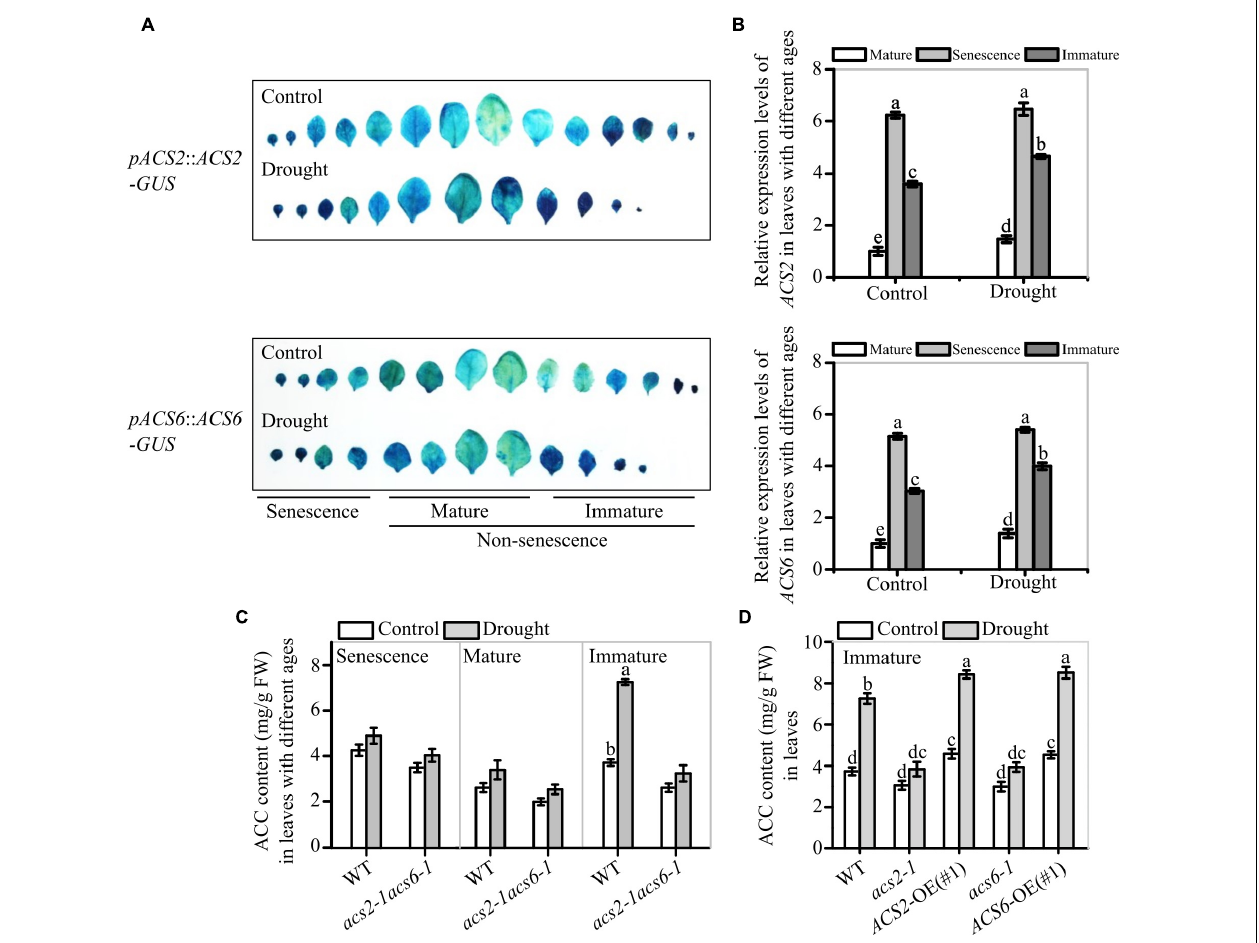
FIGURE 2 | Effects of drought on ACS2 and ACS6 expressions and ACC accumulation in leaves of different ages. (A) ACS2 or ACS6 expression was monitored in immature, mature and senescence leaves of recombinant pACS2 :: ACS2-GUS or pACS6 :: ACS6-GUS lines, respectively, with or without stopping watering (drought) treatment. Representative images are shown. Experiments were repeated three times with similar results. (B) ACS2 or ACS6 expression was monitored by RT-qPCR in immature, mature and senescence leaves of WT, respectively, with or without drought treatment. Experiments were repeated three times with similar results. Values are means ± SD. Letters indicate significant differences ( P < 0.05, two-way ANOVA). (C,D) HPLC analysis of ACC accumulation in leaves with different ages of 21-day-old seedlings with or without drought treatment. Experiments were repeated three times with similar results. Values are means ± SD. Letters indicate significant differences ( P < 0.05, two-way